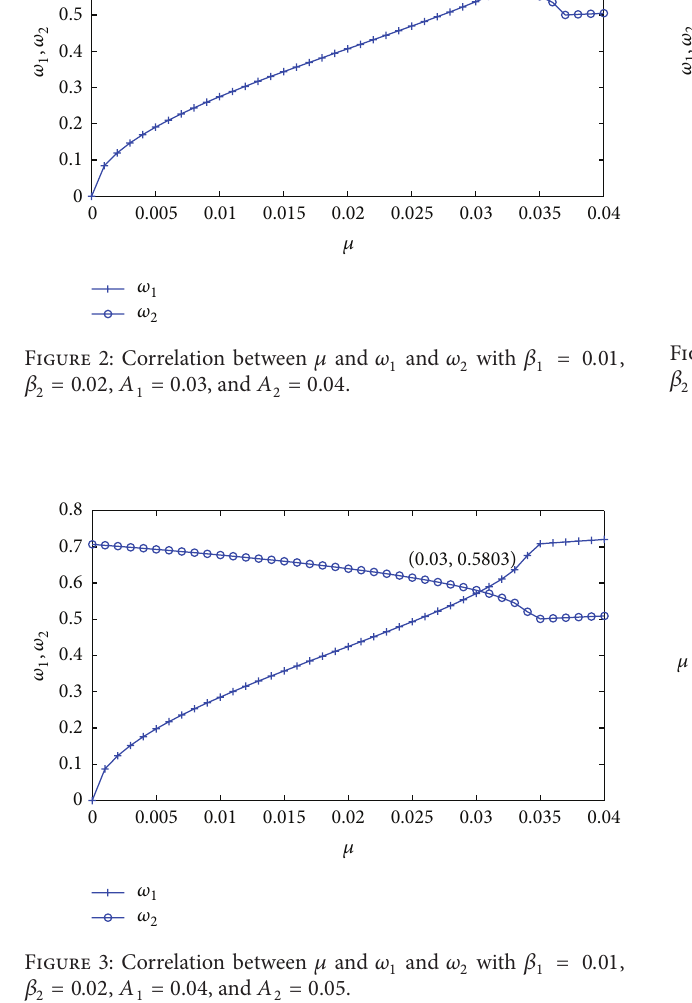
Figure 3: Correlation between 𝜇 and 𝜔 1 and 𝜔 2 with 𝛽 1 = 0.01 , = 0.02 , 𝐴 = 0.04 , and 𝐴 = 0.05 . 𝛽 2 1 2